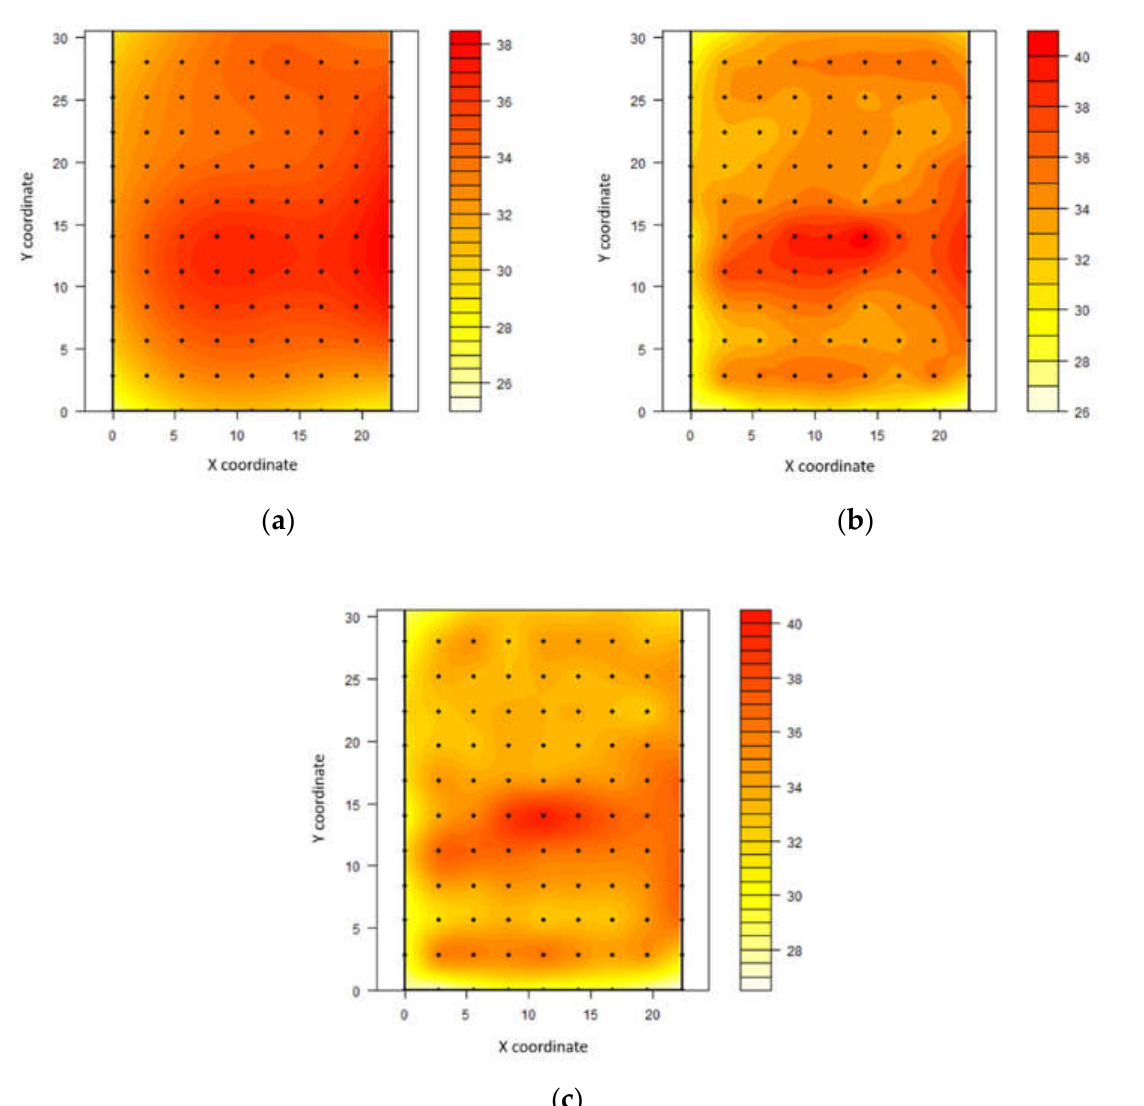
Figure 5. Spatial distribution of bed temperature (°C) in a compost-bedded pack barn between 09:00 and 12:00 h ( a ), between 12:00 and 15:00 h ( b ), and between 15:00 and 18:00 h ( c ).